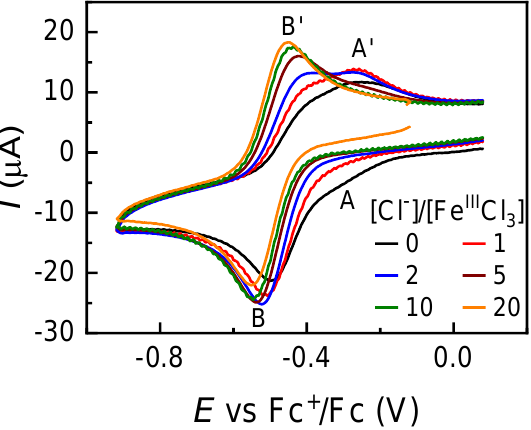
Figure 2. Cyclic voltammetry of 1 mM FeCl 3 in DMF + 0.1 M Et 4 NBF 4 recorded on a GC electrode at v = 0.2 V/s and T = 25 °C, before and after addition of different amounts of Et 4 NCl.